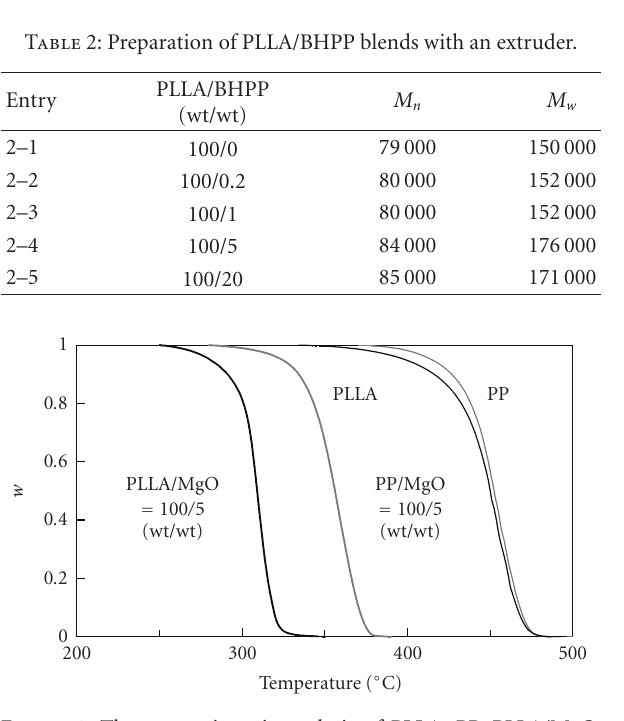
Figure 1: Thermogravimetric analysis of PLLA, PP, PLLA/MgO, and PP/MgO. ϕ = 9 ◦ Cmin − 1 .